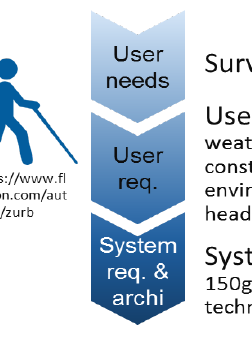
Figure 2. INSPEX methodology.